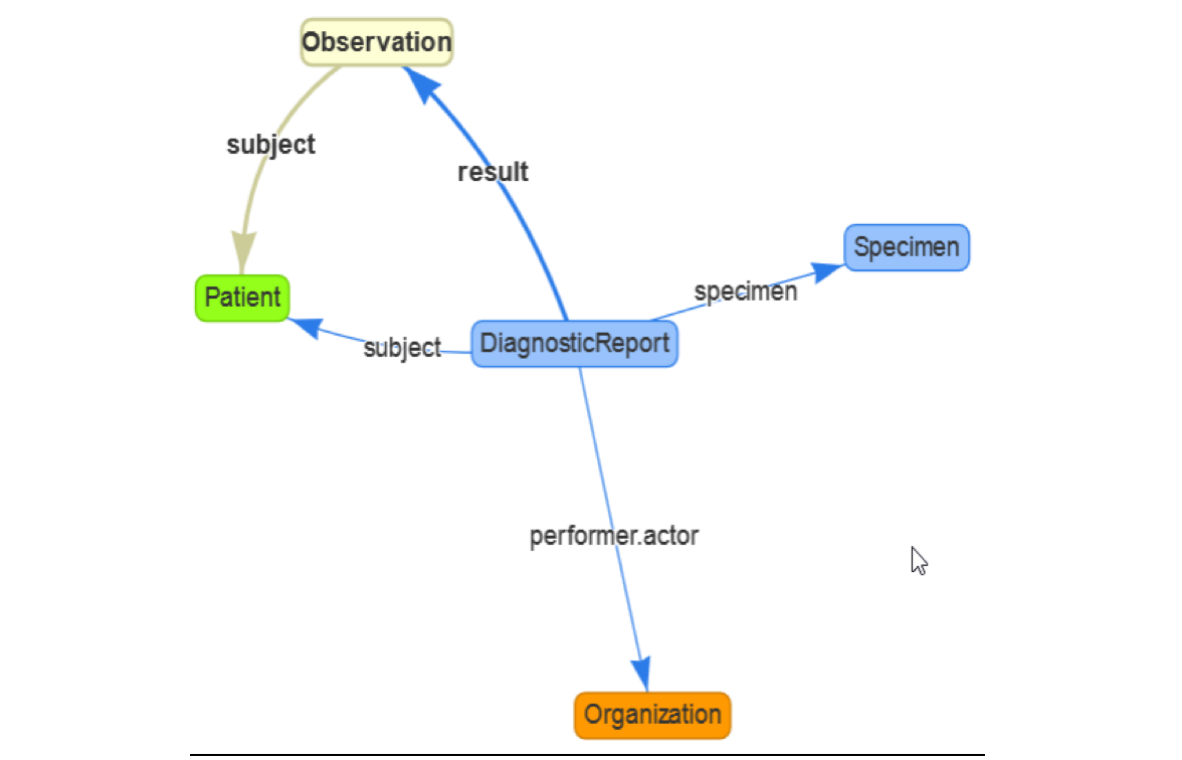
Resource and elementFHIR a Field